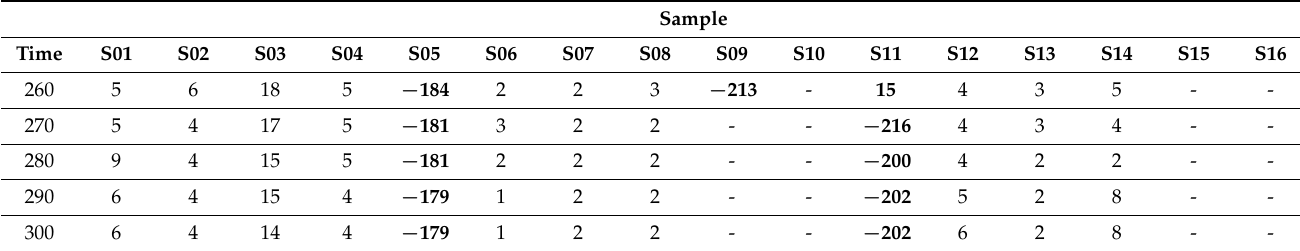
Figure 9. The difference between the measured values by image analysis and a laser distance meter for first measurement, i.e., maximum height of beer foam.